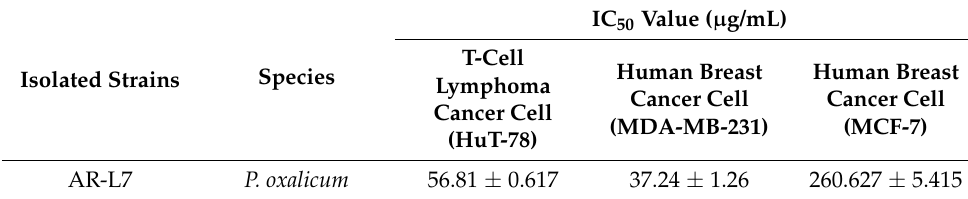
Table 3. Cytotoxic activity of EA extract of P. oxalicum associated with the leaf of A. rohituka .